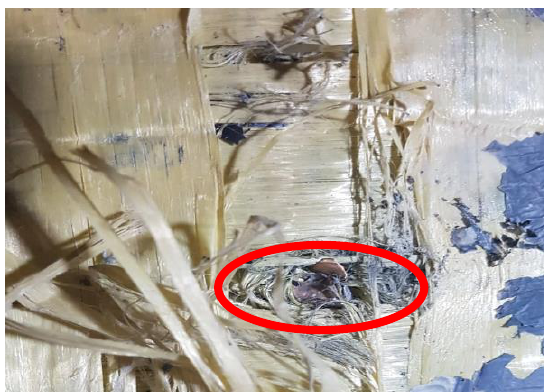
Fig.2: Ballistic test by handgun bullets of 9*19 mm from a distance of 7 m.